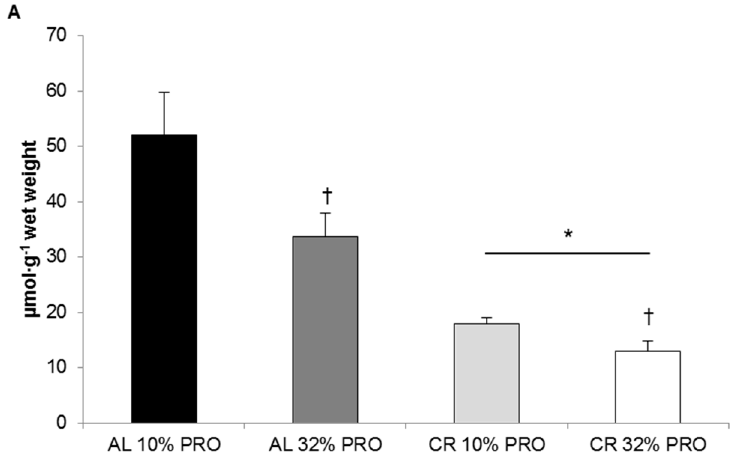
Figure 1. Intrahepatic triglyceride content. Values presented as mean ± SEM. * Main effect of energy status, calorie restriction (CR) different than ad libitum (AL); p < 0.05. † Main effect of protein (PRO), 32% PRO different than 10% PRO; p < 0.05.